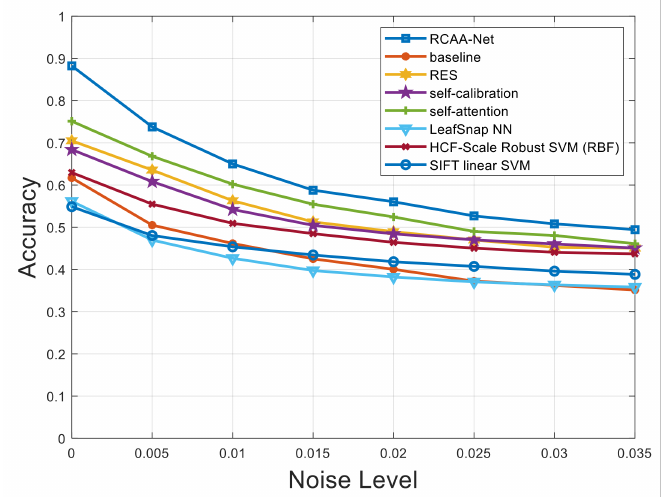
Figure 7. Recognition accuracy results when adding different levels of Gaussian